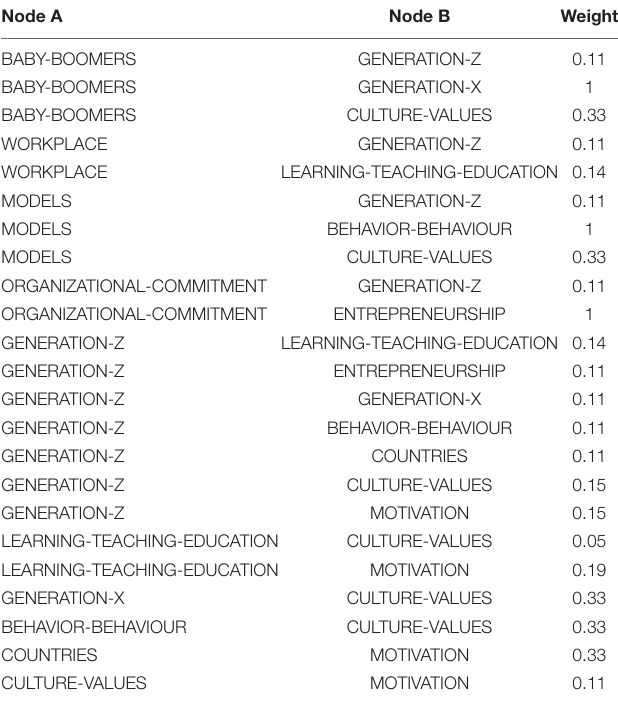
TABLE 7 | “Generation-Z” Cluster Network 2018. Node A Node B